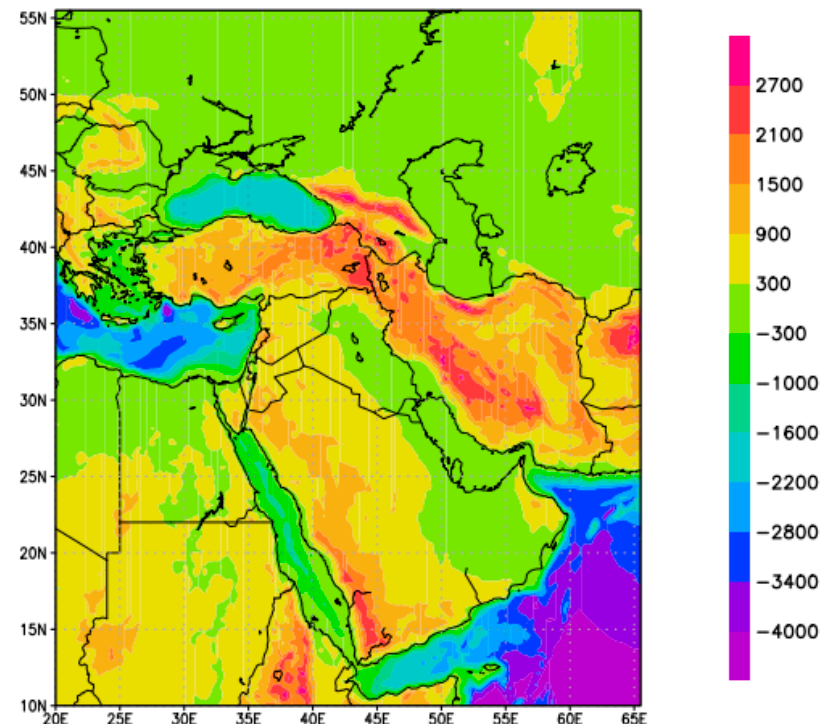
Figure 1. Spatial map showing topography of the study area.